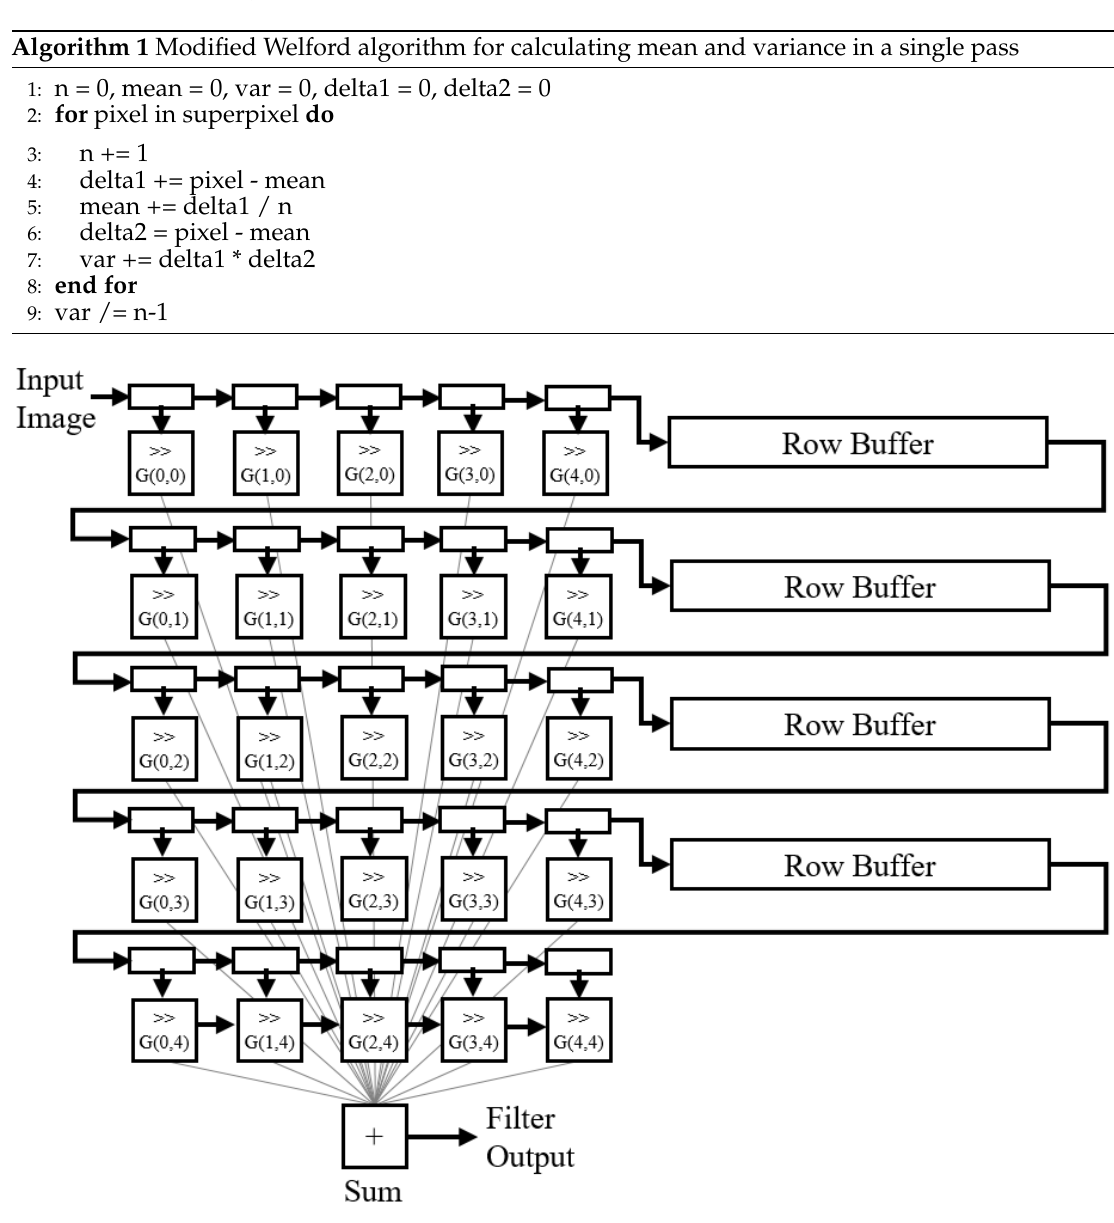
Figure 7. A block diagram showing a 5 × 5 Gaussian blur operator in hardware, where >> indicates a right shift and G is a matrix representing the Gaussian